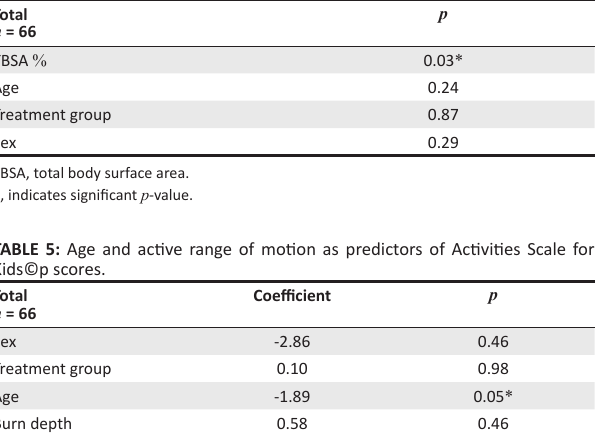
TABLE 4: Total body surface area percentage associated with Activities Scale for Kids©p scores. Total n =